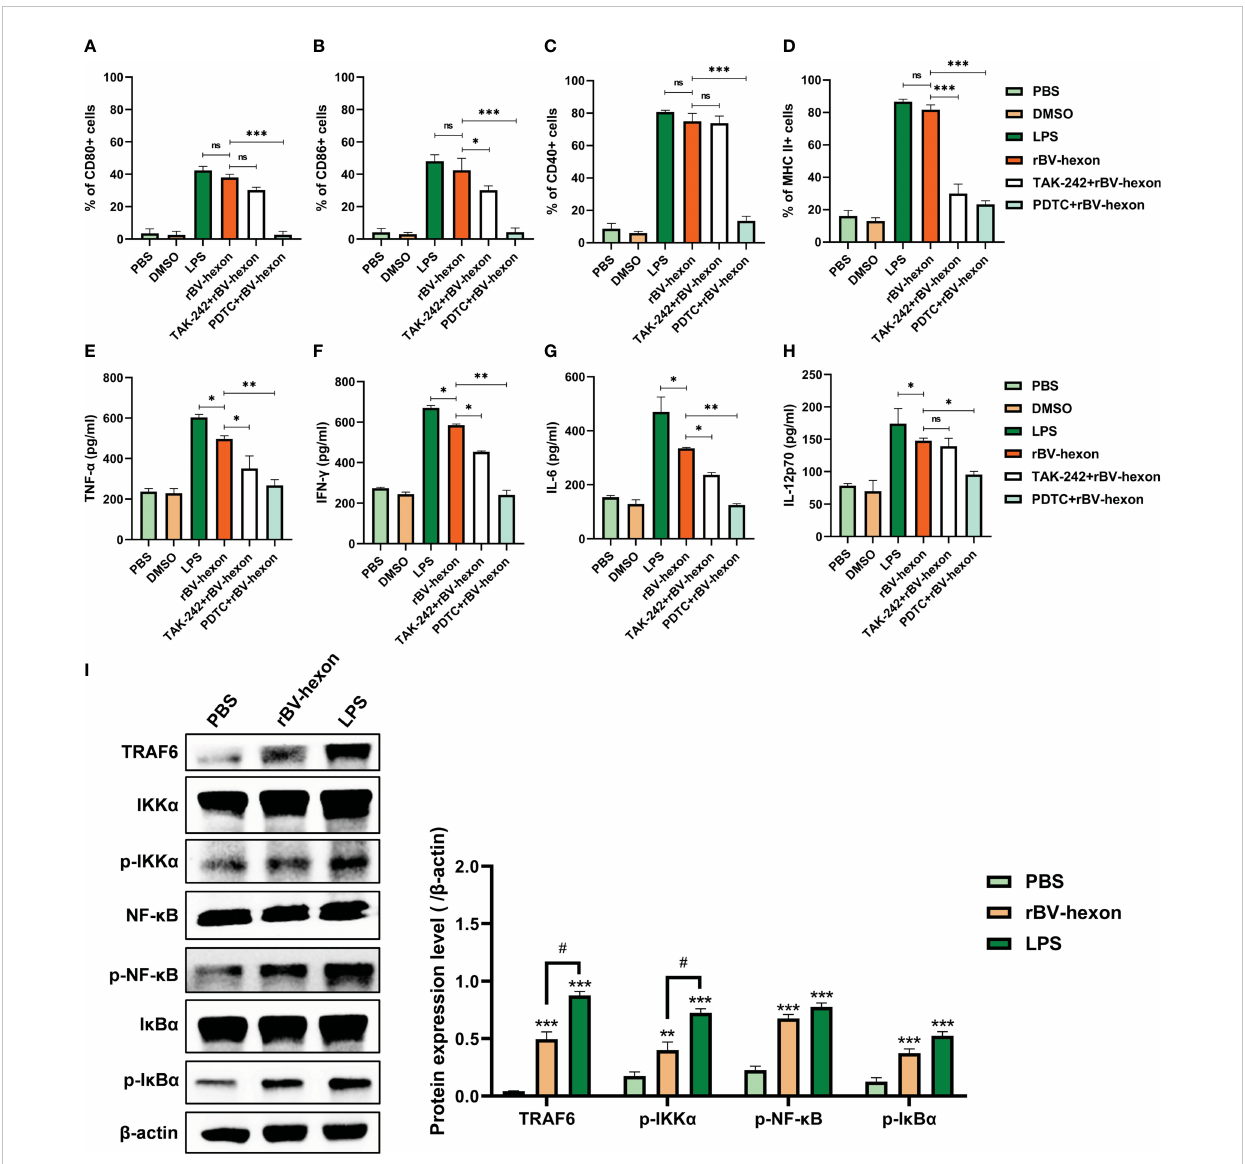
FIGURE 3 Blocking TLR4 and NF- k B inhibits DC maturation. After treatment with TLR4 and NF-kB inhibitors, DC surface molecules CD80 (A) , CD86 (B) , CD40 (C) and MHC II (D) were detected by fl ow cytometry. ELISA was used to test the secretion of TNF a (E) , IFN g (F) , IL-6 (G) and IL-12p70 (H) . (I) Whole cell proteins were extracted, and the expression of key proteins in the TLR4/NF- k B pathway in macrophages was detected by Western blot. The experiments were repeated over three independent experiments. Error bars represent the standard deviation (SD). * P < 0.05; ** P < 0.01, *** P < 0.001. P < 0.05. ns, no signi fi